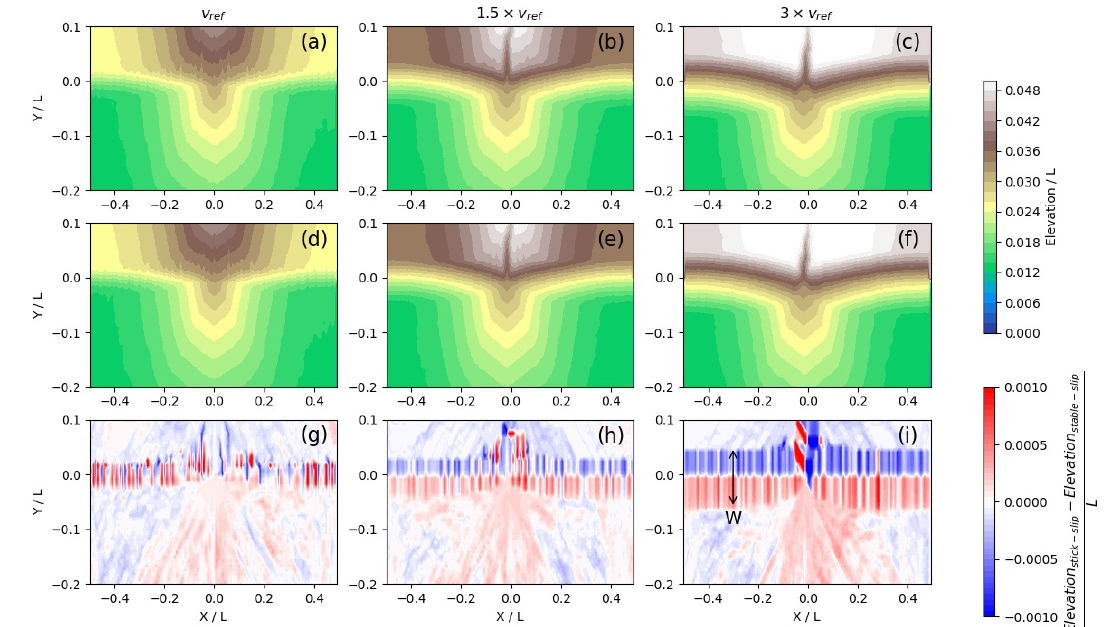
Figure 11. Morphological signature of fault slip rate. ( a ) Elevation associated with stick-slip behavior assuming the fault slip rate v ref used in the numerical reference model (see Table 1). ( b , c ) same as ( a ), assuming a fault slip rate of 1.5 × v ref and 3 × v ref , respectively. ( d – f ) same as ( a – c ), assuming a stable sliding. ( g – i ) elevation deviation between slick-slip and stable sliding for a fault slip rate of v ref , 1.5 × v ref , and 3 × v ref , respectively. W is the width of the zone with a high elevation deviation.